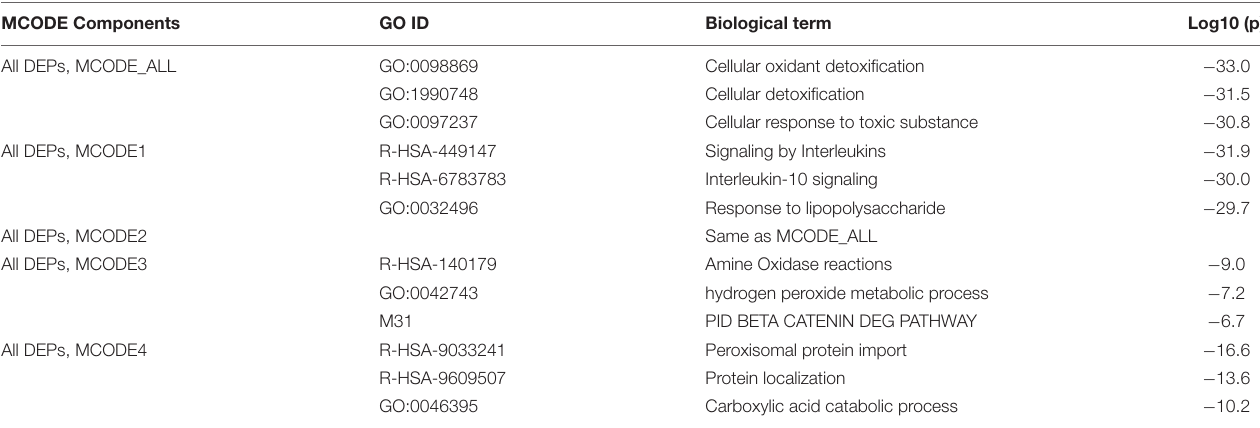
Protein-DNA complex FDR: false discovery rate.